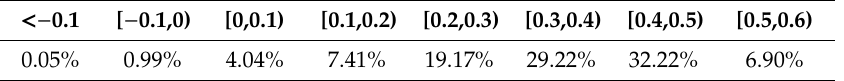
Figure 7. The relative EVPL (REVPL, 99%) results for the date of 2017day121. It shows that in about 99% of the region, using the modified paired overbound method can achieve better EVPL results than the traditional one. Table 1. The proportion of users with di ff erent rates of growth in Figure 7. < − 0.1